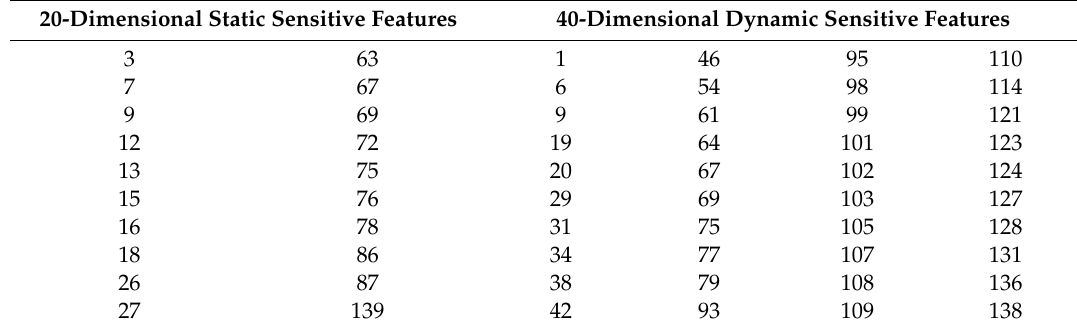
Table A1. 20-dimensional static sensitive features and 40-dimensional dynamic sensitive